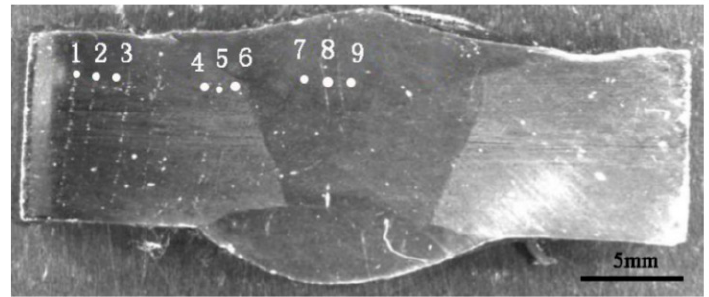
Figure 1. Microhardness point location.